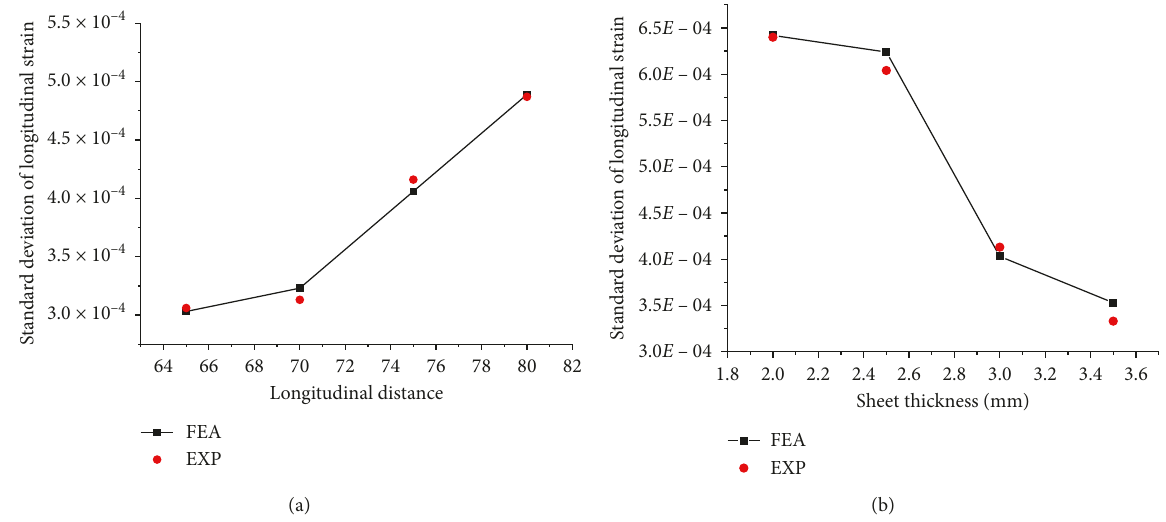
Figure 17: (a) Effect of flange height on longitudinal strain. (b) Effect of sheet thickness on longitudinal